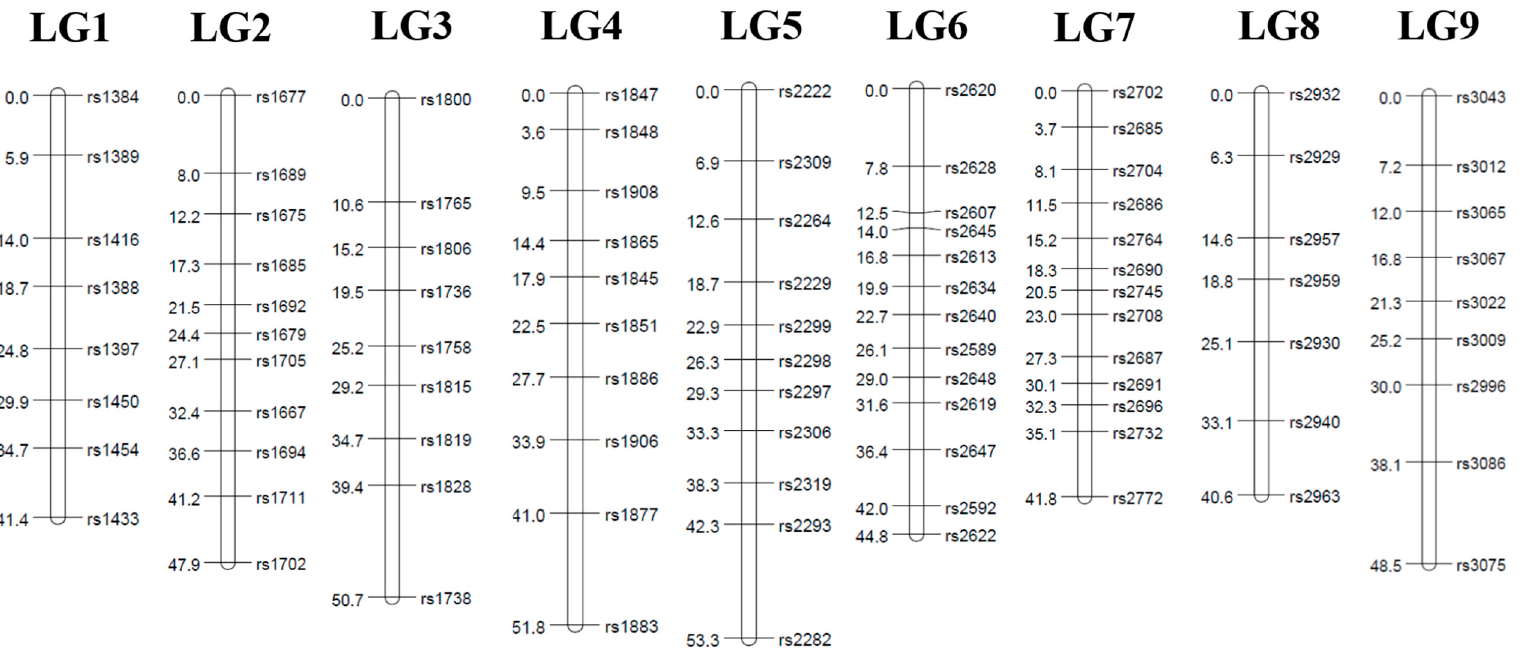
Figure 4. Genetic linkage map of GX71 constructed from an outbred population between GX50 and GX71. The map was constructed from 91 SNPs discovered and genotyped using GBS, including SNPs from all three pseudo-testcross segregation types